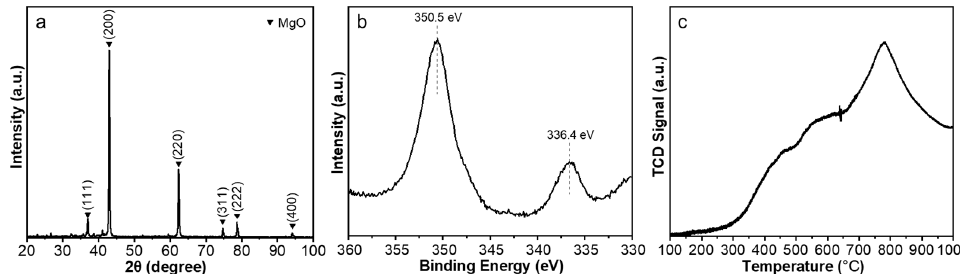
Figure 3. ( a ) XRD patterns, ( b ) XPS spectrum, and ( c ) H 2 -TPR profile of atomically dispersed Pd@MgO catalyst.